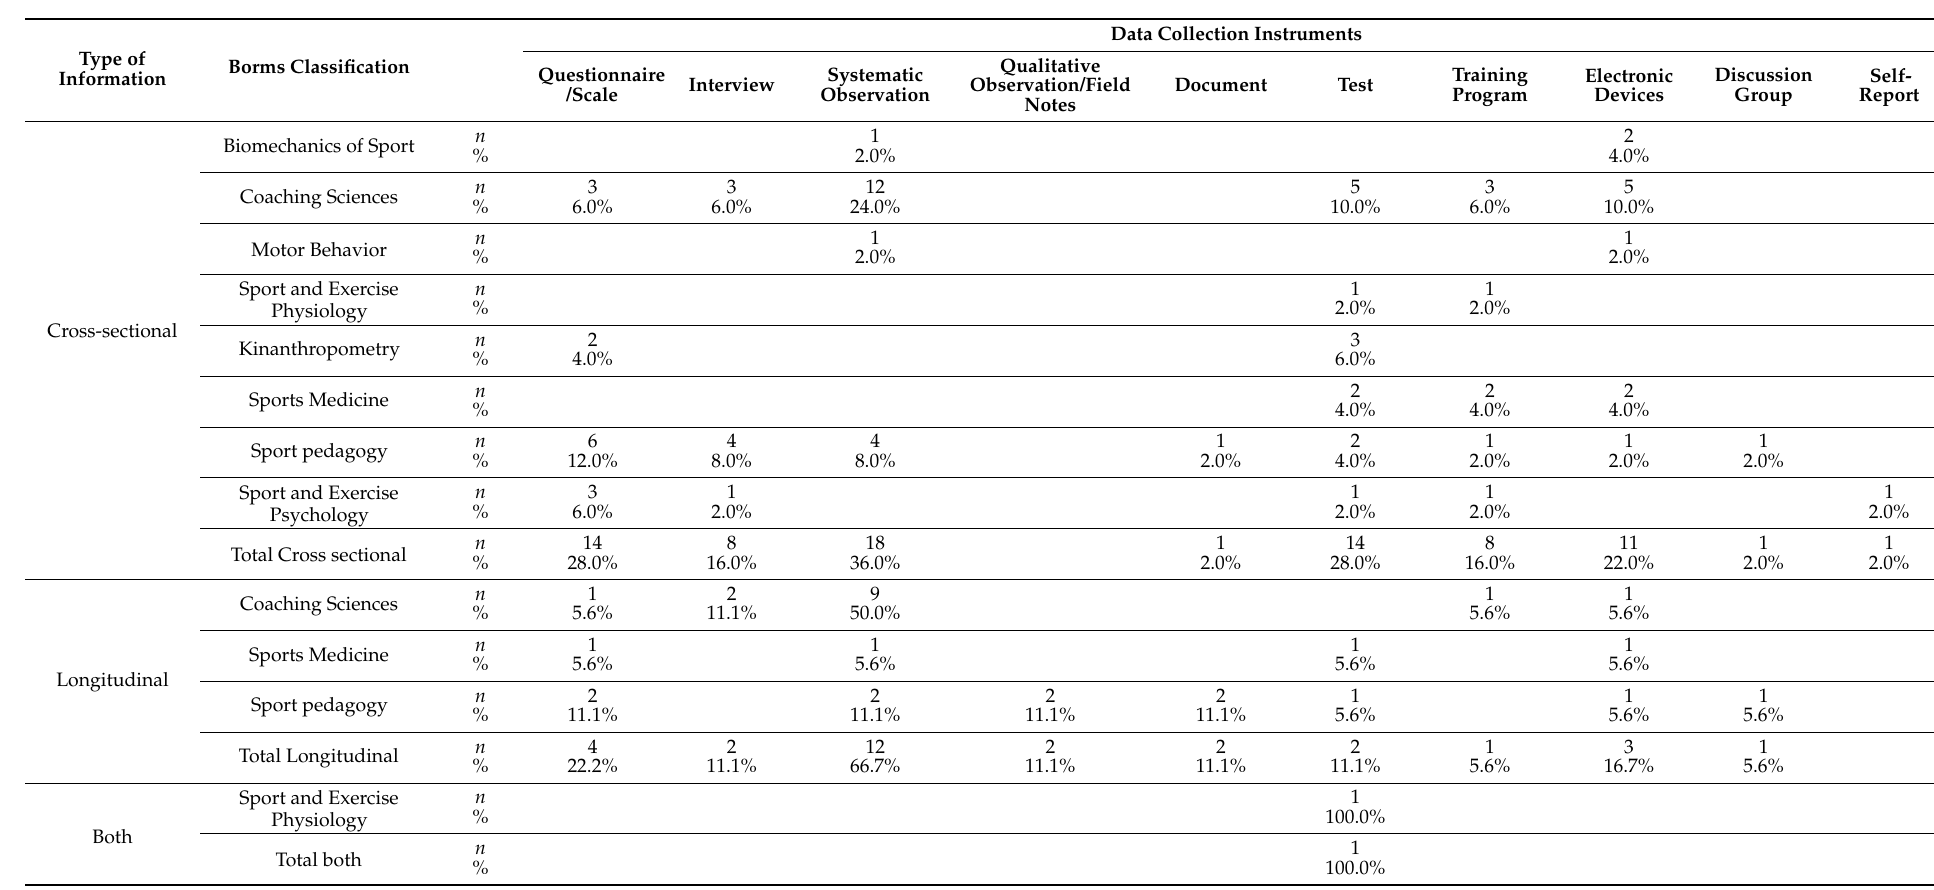
Table 2. Interaction of the data between classification and research procedures relating the variables of type of information, the Borms classification [33] and the data collection instruments. Type of Information